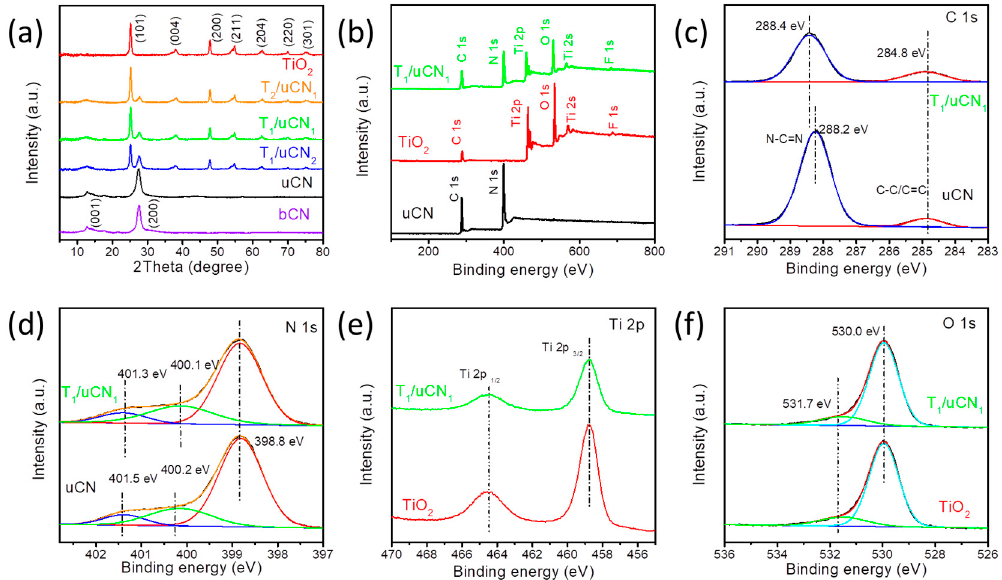
Figure 3. ( a ) XRD patterns of TiO 2 , uCN and T/uCN. ( b ) XPS survey spectrum of TiO 2 , uCN and T/uCN; high-resolution XPS spectra at the regions ( c ) C 1s, ( d ) N 1s, ( e ) Ti 2p and ( f ) O 1s.